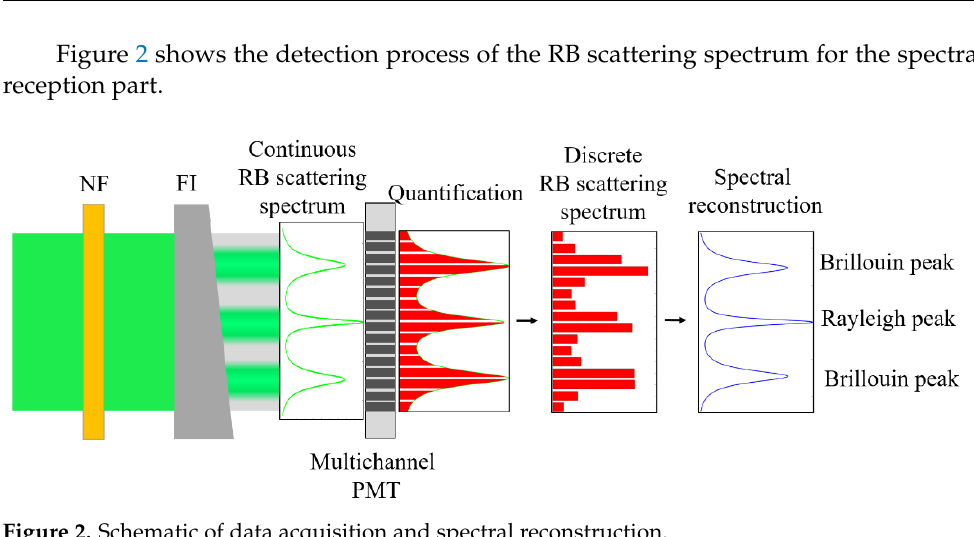
Figure 2. Schematic of data acquisition and spectral reconstruction. The backscattered light passes through the Fizeau interferometer (FI). Under the after FI, and a continuous RB scattering spectrum is formed and exactly distributed on